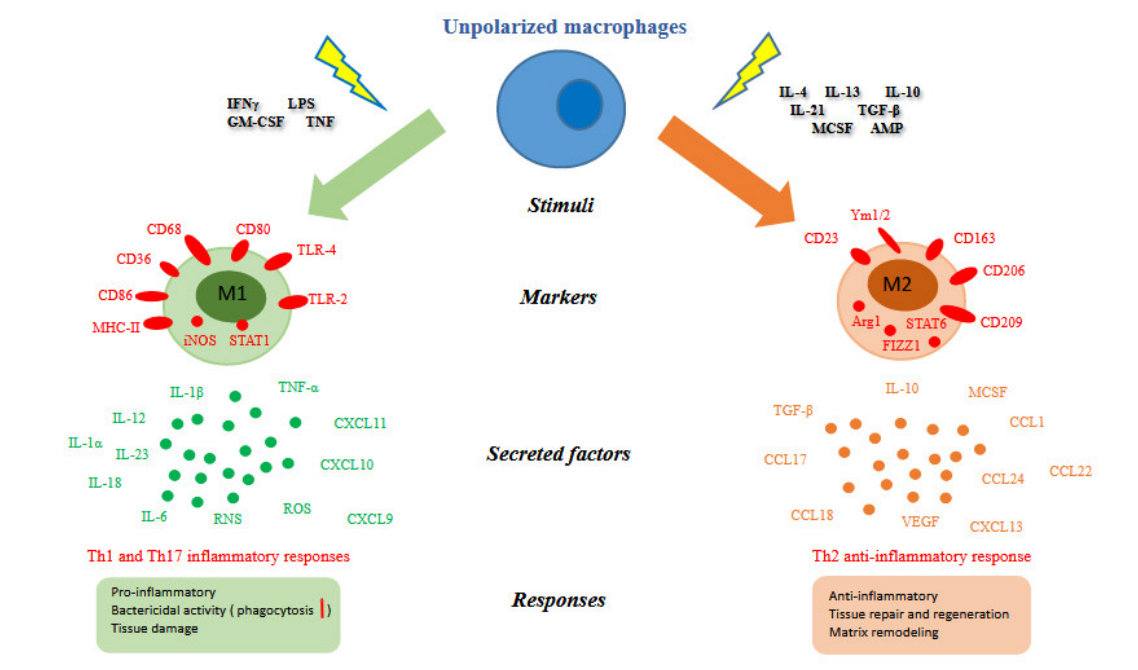
Figure 2. Macrophage polarization. Different stimuli, surface and intracellular markers, secreted factors and biological responses [22–24] between M1 and M2 macrophages were summarized. Ab- breviation: IFNγ (interferon gamma); LPS (lipopolysaccharide); GM-CSF (granulocyte-macrophage